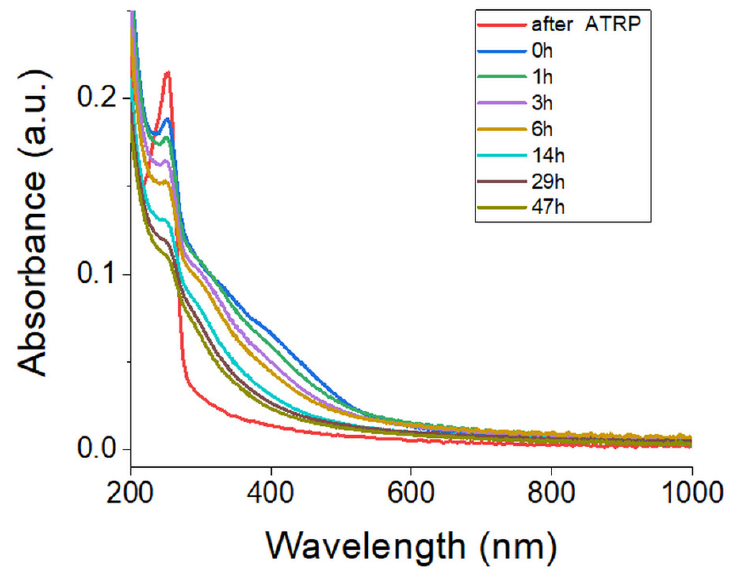
Figure 11. UV-Vis spectra of the Poly(ProDOT)-Poly(MM) brushes grafted from quartz (25 nm thick) at different times after irradiation under ambient conditions. The spectrum of nonconjugated ProDOT)-Poly(MM) brushes (after ATRP) is shown for comparison.